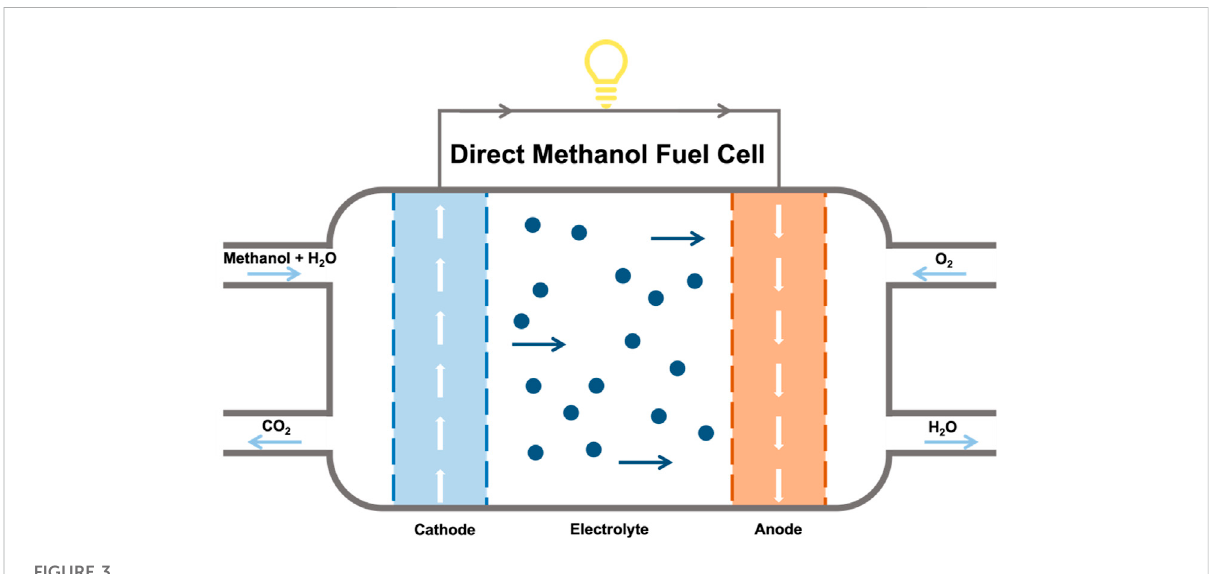
FIGURE 3 The con fi guration and components of the